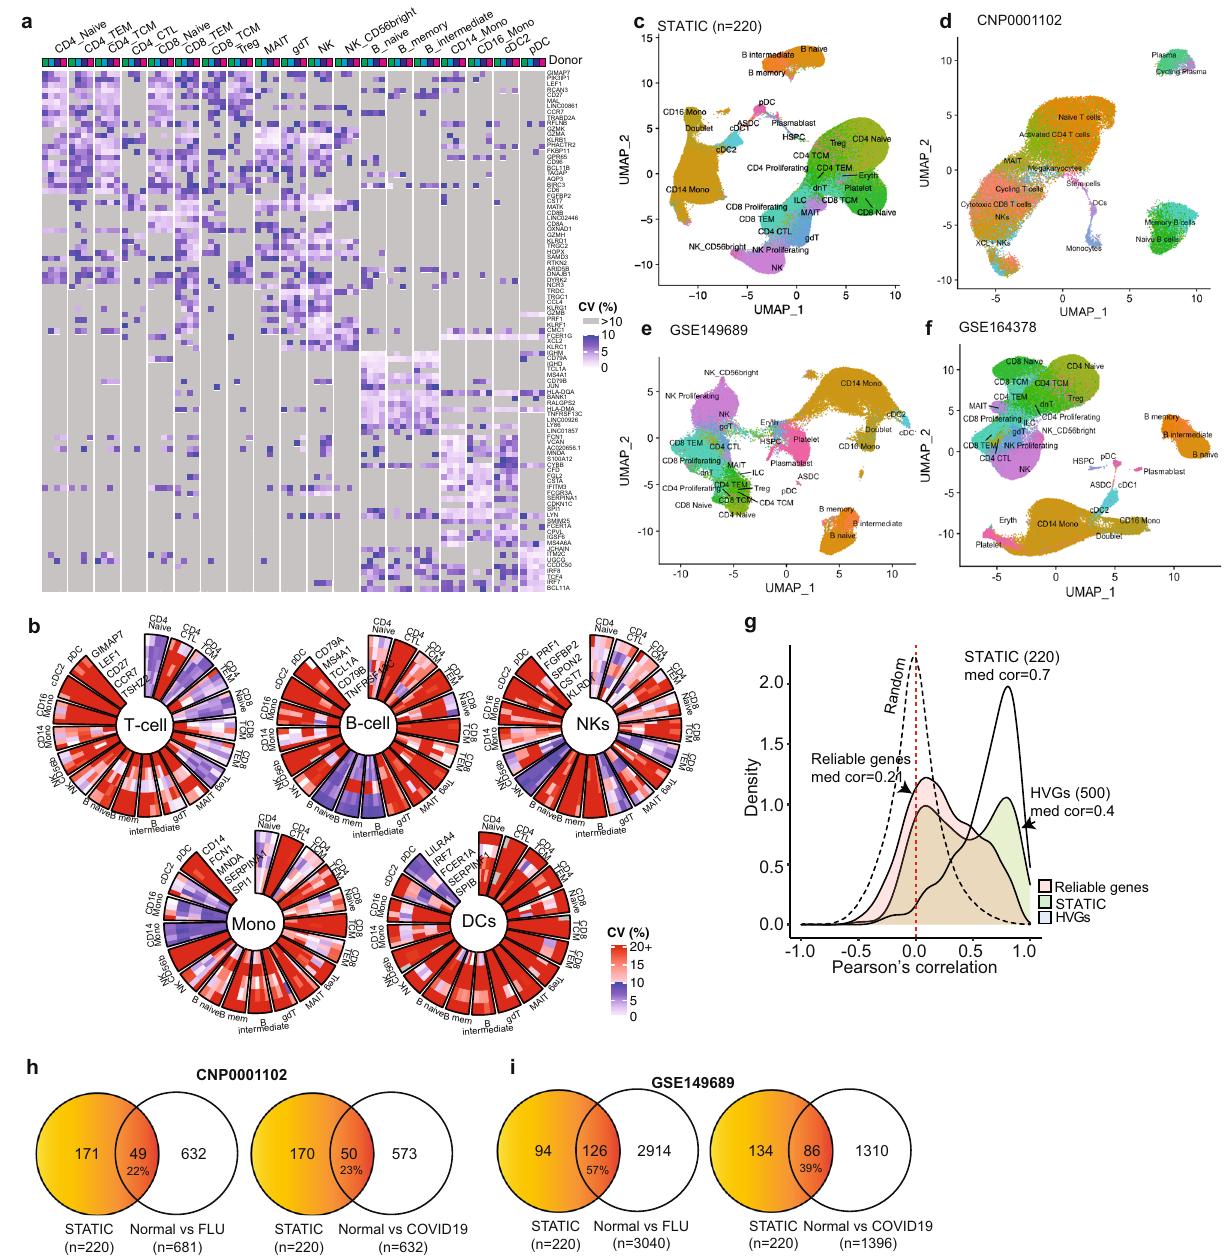
Fig. 4 | Properties of 220 STATIC genes of PBMC. a Heatmap of coef fi cient of variation (CV) evaluated on 93 out of the 220 stable across time in cell-types (STA- TIC) genes that were identi fi ed from 19 cell types in the longitudinal scRNA-seq data of n =4 healthy participants. The CVs for each of the n =4 participants were eval- uated based on pseudo-bulk intensities in the corresponding 6 independent per- ipheralbloodmononuclearcell(PBMC)samples.The93STATICgenesincludeupto ten top STATIC genes from individual cell types. b Circos plots displaying CV of fi ve example STATIC genes identi fi ed from each of fi ve major cell types: T cells, B cells, natural killer (NK) cells, monocytes (Mono), and dendritic cells (DCs). c Uniform ManifoldApproximationandProjection(UMAP)usingonlythe220STATICgenesas input features (sUMAP) on the same longitudinal scRNA-seq data. d – f sUMAP using the same 220 STATIC genes on three external PBMC datasets (( d ) CNP0001102 3 , ( e ) GSE149689 2 , ( f ) GSE164378 16 ), where cells are labeled as in the original studies.